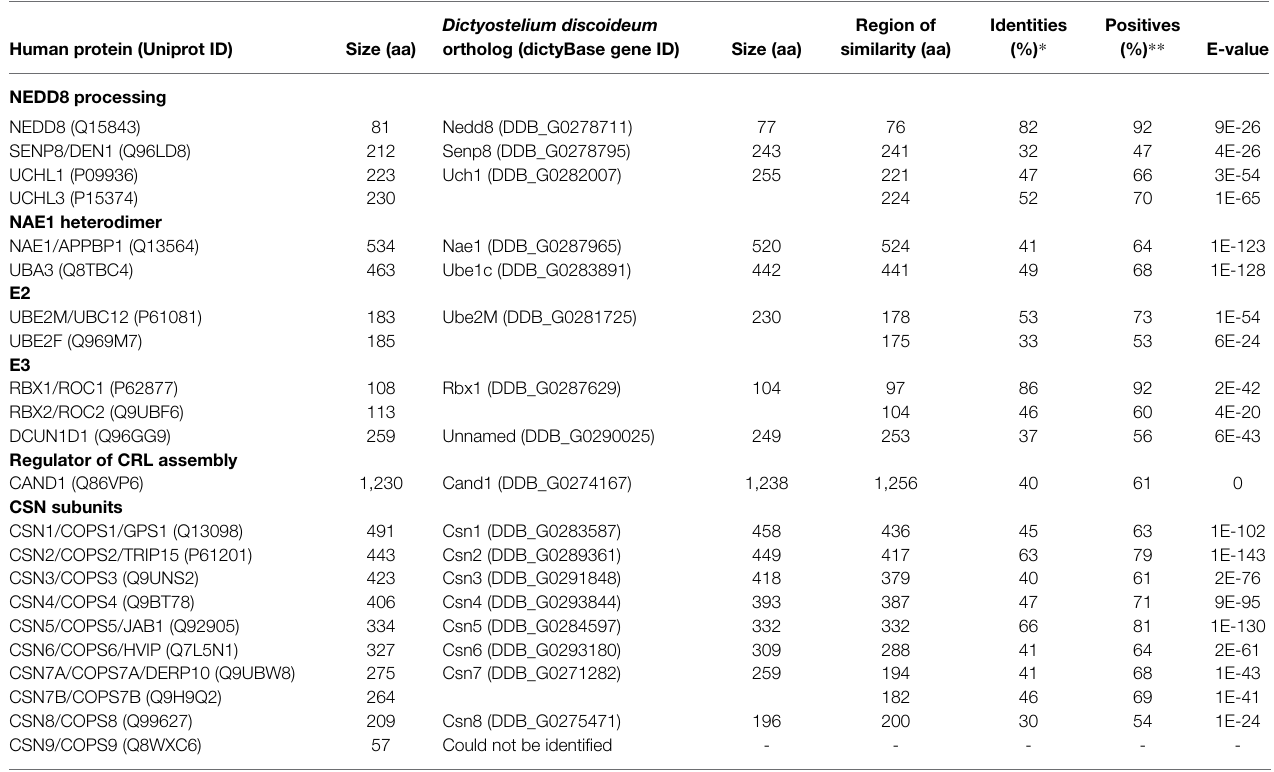
TABLE 1 | Sequence similarity between neddylation pathway proteins and CSN subunits in humans and Dictyostelium discoideum .